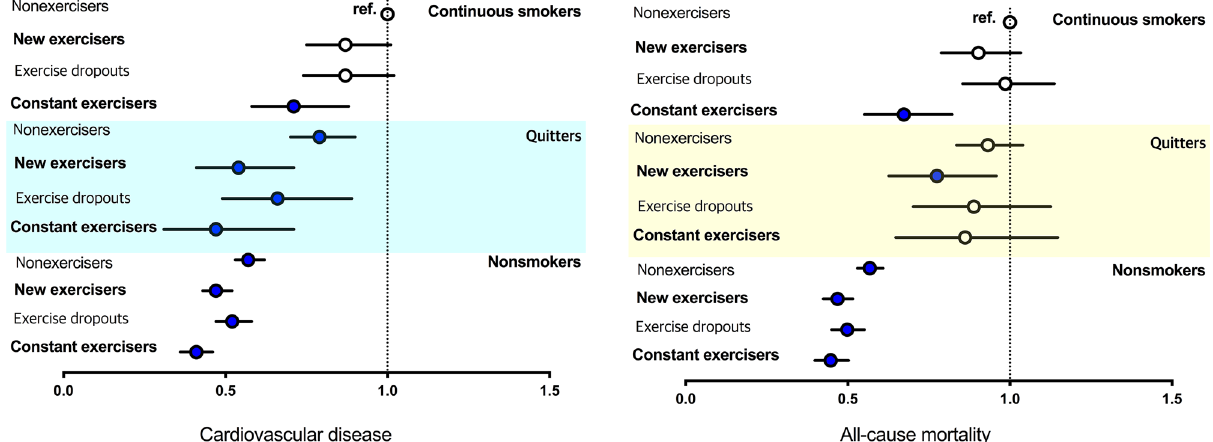
Figure 2. Hazard ratios and 95% confidence intervals for cardiovascular disease (left panel) and all-cause mortality (right panel) according to the changes in smoking and exercise habits after the diagnosis of diabetes mellitus. The group of continuous smokers and nonexercisers was defined as the reference group. The analysis was adjusted for age, sex, body mass index, income status, hypertension, dyslipidemia, fasting blood glucose level, kidney function, use of insulin, number of oral hypoglycemic agents, and alcohol